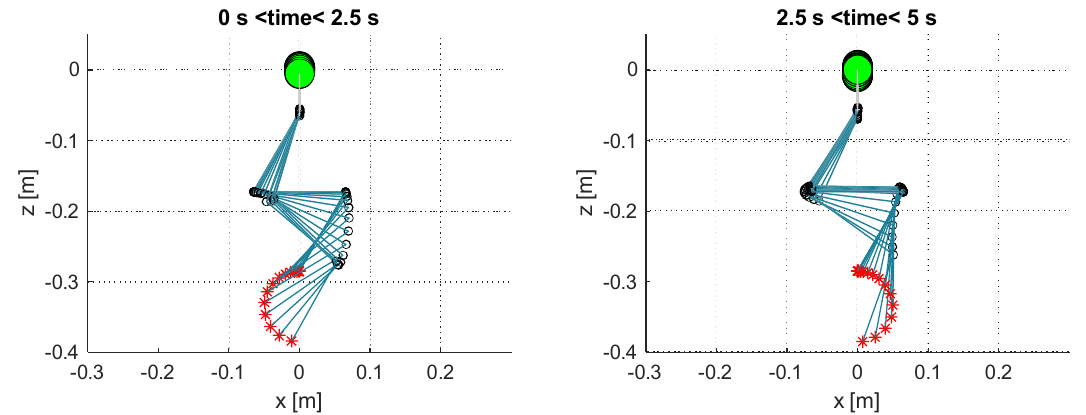
Figure 19. Stroboscopic trajectories for the first half ( left ) and second half ( right ) of the circular trajectory task for the 3-DOF redundant UAM using the extended generalized Jacobian. The UAV base is the large green marker, joints are the black circles, links are the blue lines, and end-effector positions tracked are the red crosses.